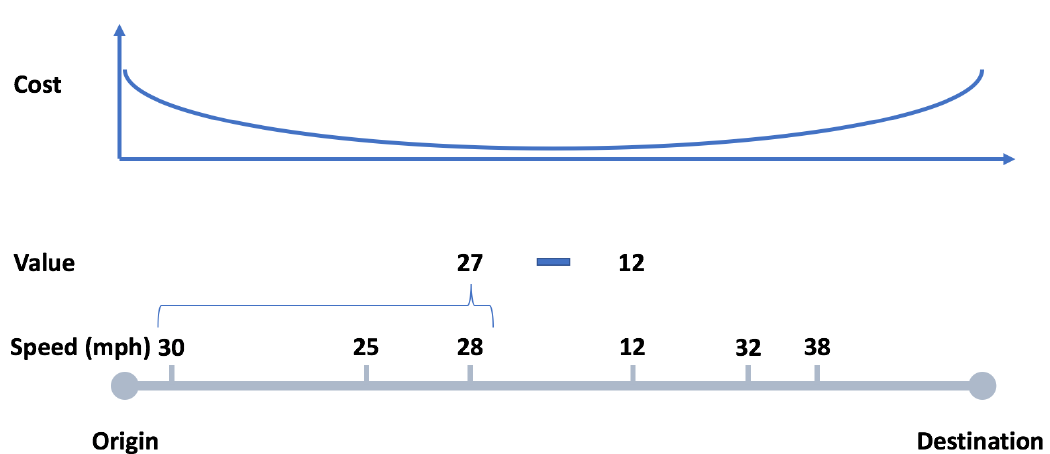
Figure 1. Definition of costs and values in the traffic data. Costs are defined as the distance from the source and the destination, with the assumption that knowing these location conveys privacy-sensitive information. The costs are maximal at the source and at the destination, and decrease in between. Values are defined as the difference between the current speed and the average past speed, with the assumption that a sudden change of speed conveys information about traffic